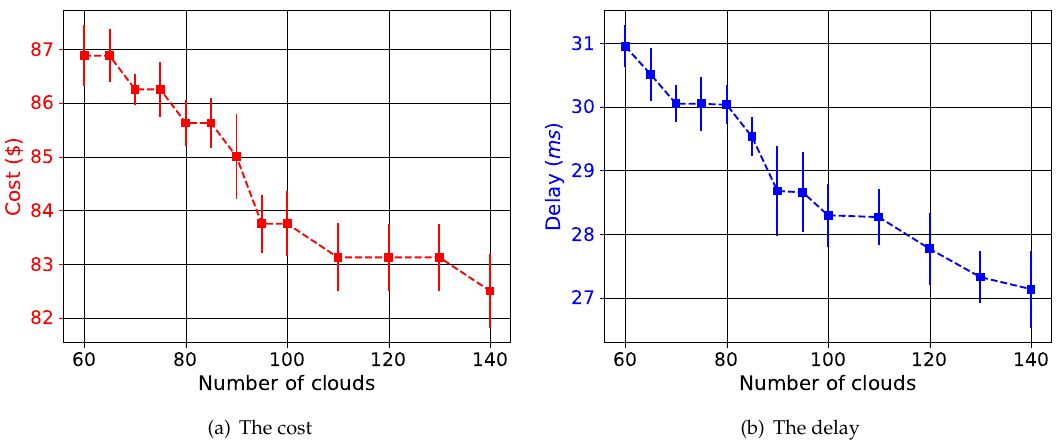
Figure 9. Cost and Delay of the security